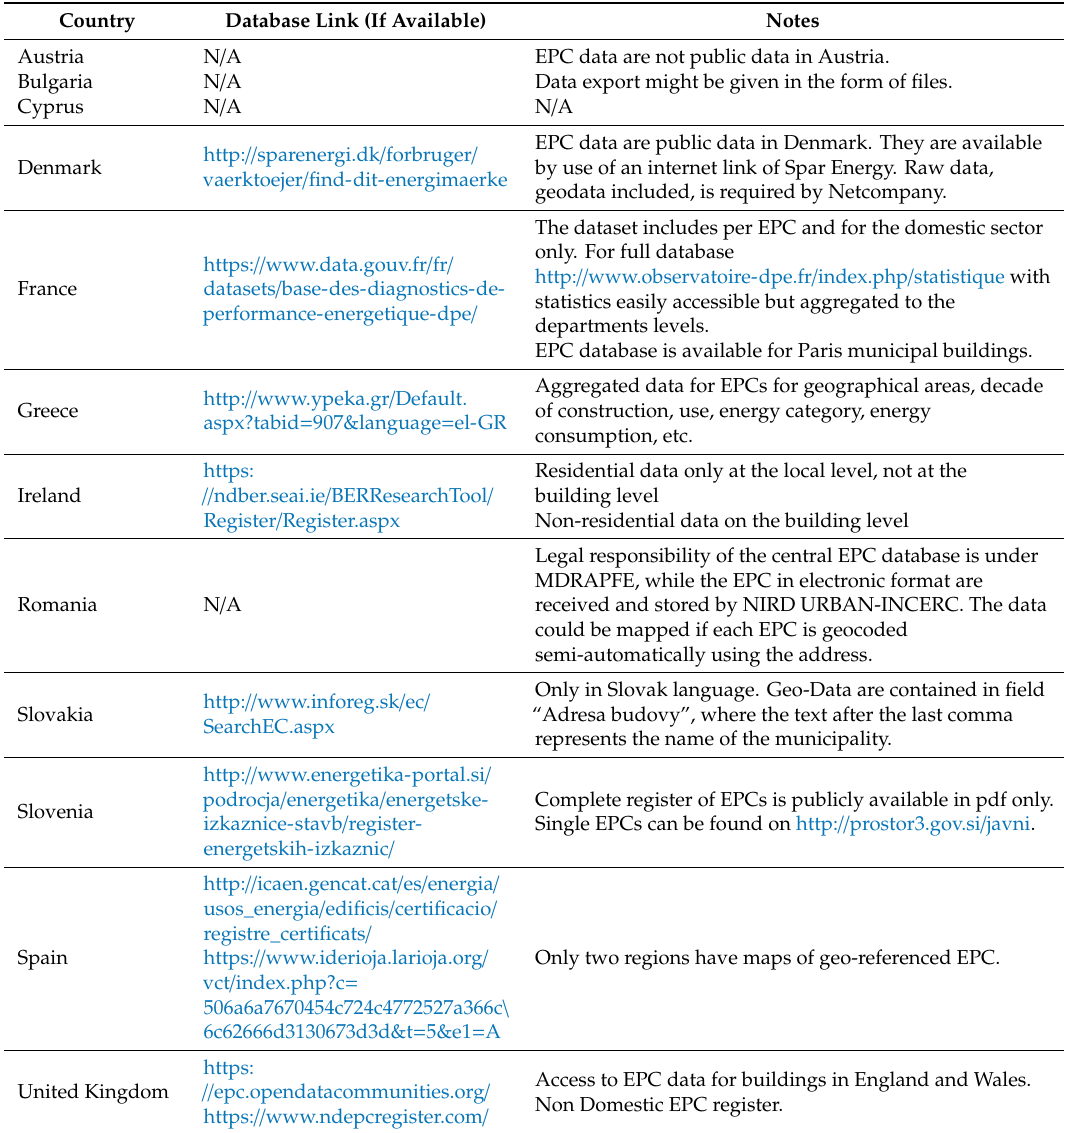
Table 2. Database per partner country for uploading data to the ENERFUND